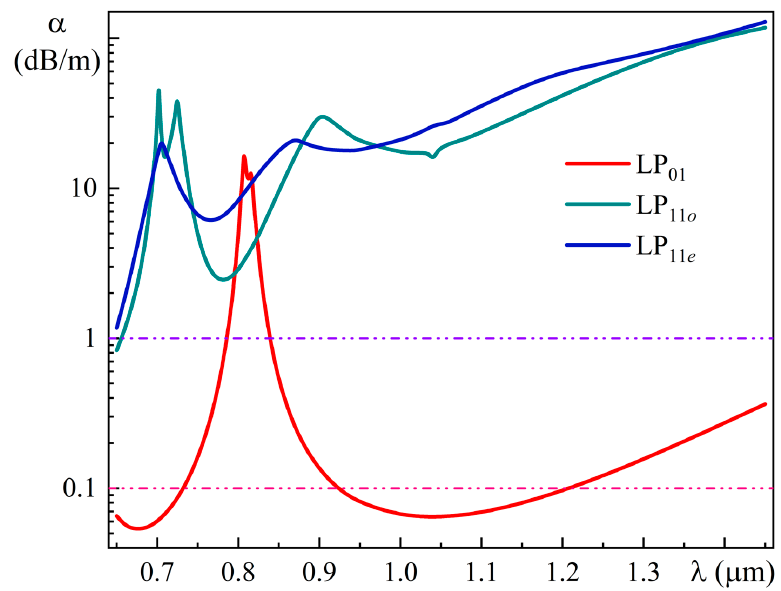
Figure 13. Spectral dependences of leakage losses in a MOF-18 for the fundamental (LP 01 ) and higher-order (LP 11 o and LP 11 e ) modes at a bending radius of 0.08 m averaged over bend directions. As can be seen from Figure 13, the spectral range of the single-mode regime for the bent MOF-18 for bending radius of 0.08 m is from 0.92 µm to 1.21 µm. The leakage losses